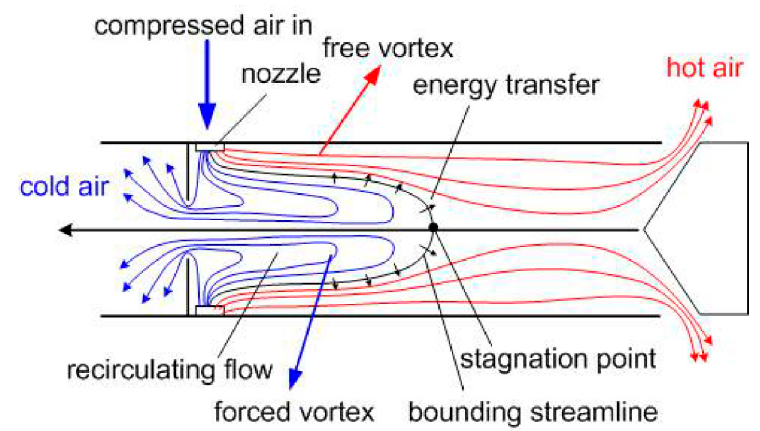
Figure 2. Supposed flow pattern and energy flow in the counter flow type.